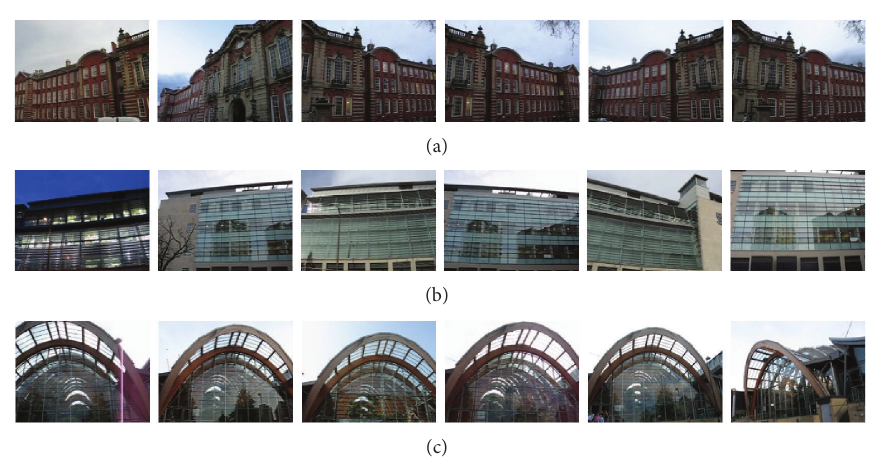
Figure 6: (a)–(c) are sample images from categories 1, 10, and 31,